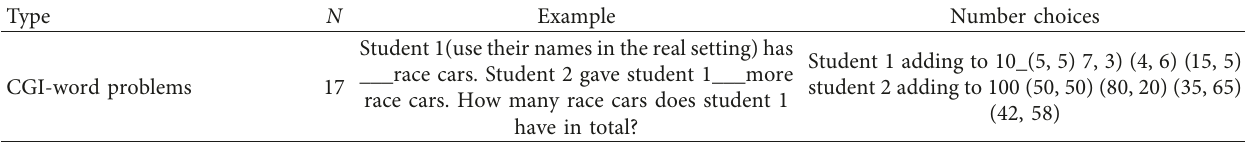
Table 8: Nature of tasks selected and/or generated during the tutoring